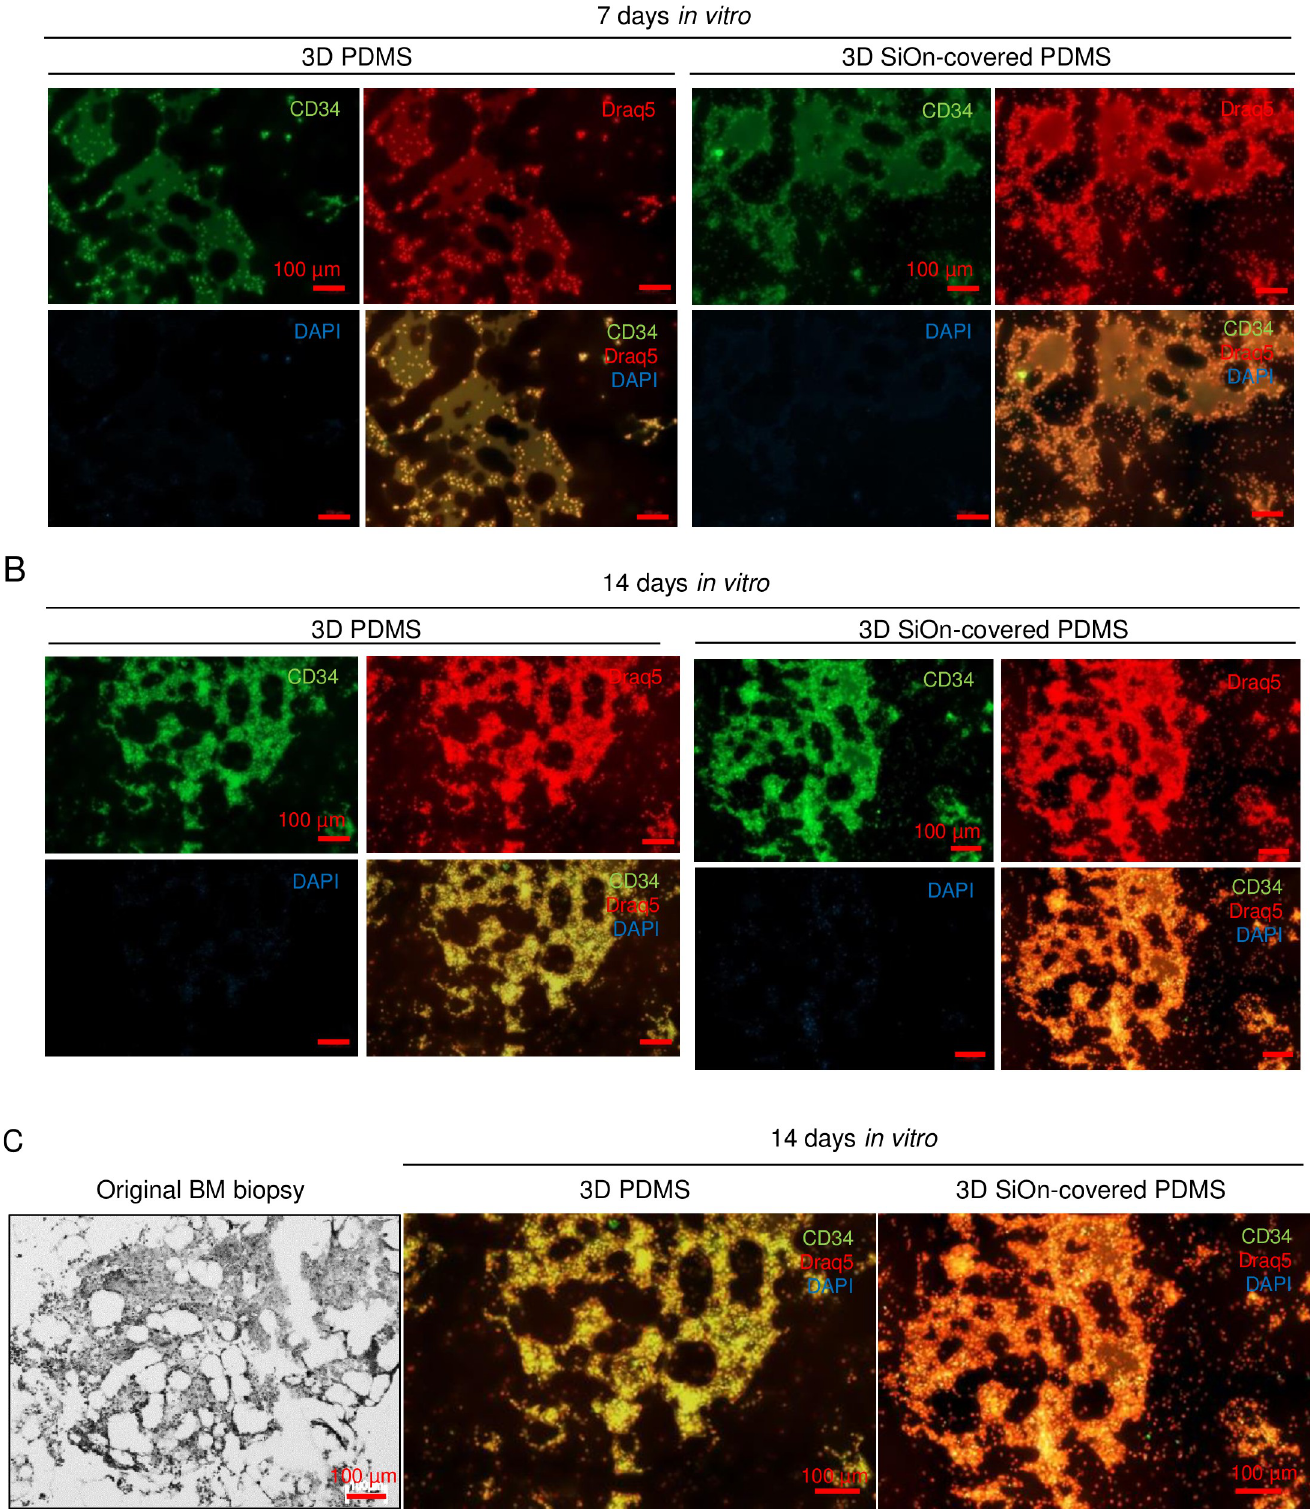
Fig 4. Microscopy of human HSCs cultured on SiOn-covered and uncovered 3D PDMS structures. Human HSCs were cultured in HSC medium supplemented with 1 mM VPA on SiOn-covered and uncovered 3D PDMS scaffolds. All cell nuclei were stained with Draq5 (red) and dead cells were stained by DAPI uptake (blue)